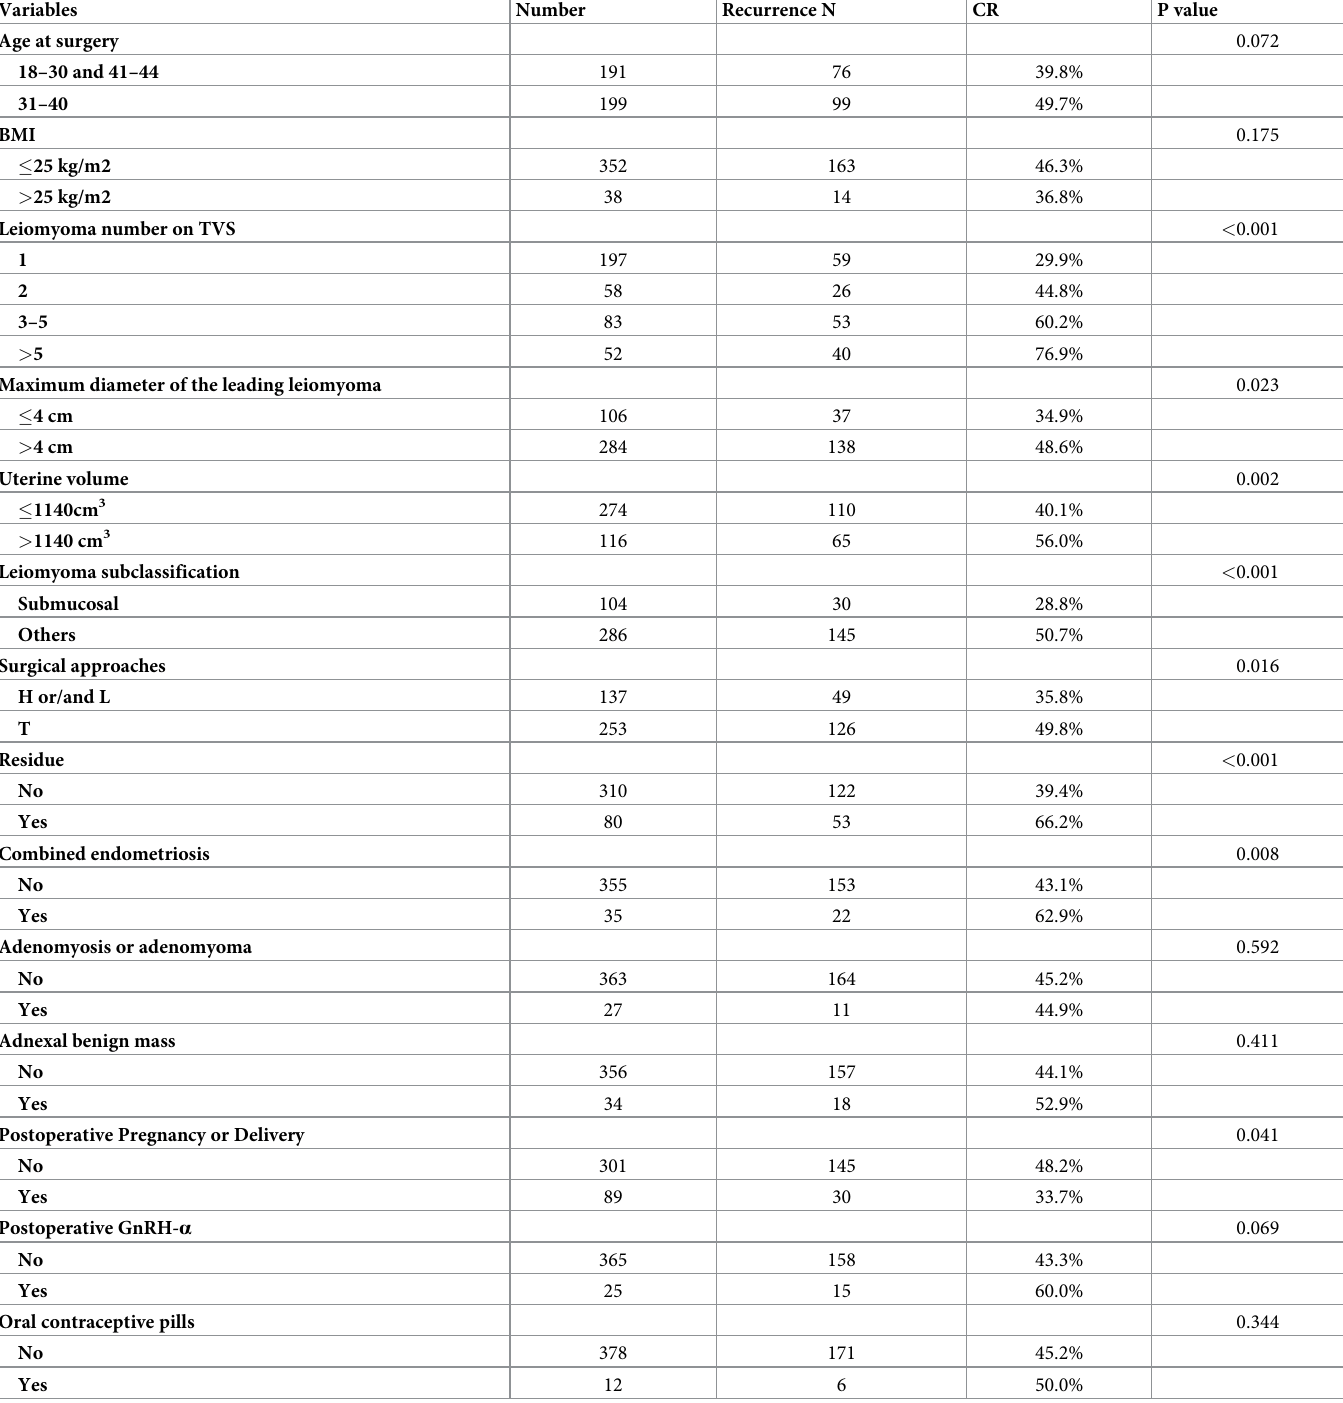
Table 1. Univariate analyses of variables in the model group by the Kaplan–Meier